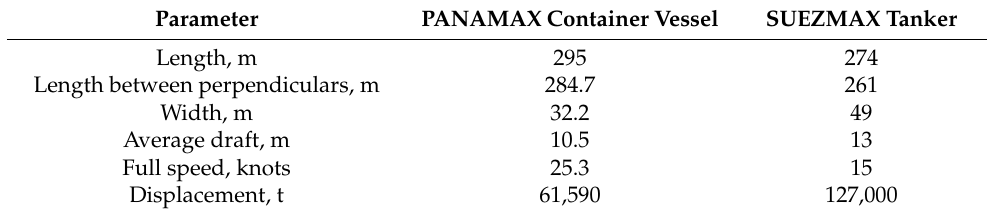
Table 2. Selected parameters of analyzed ships [18,23,67].